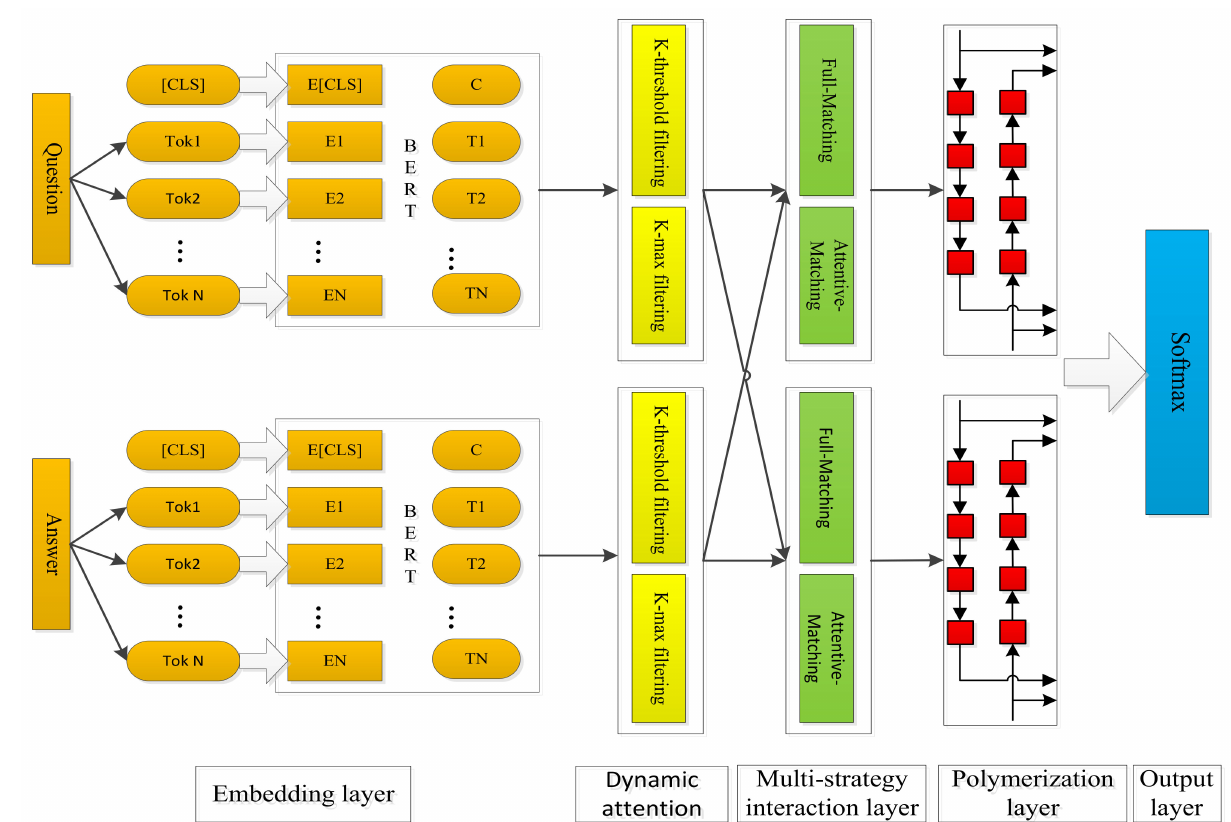
Figure 1. DSMM model architecture